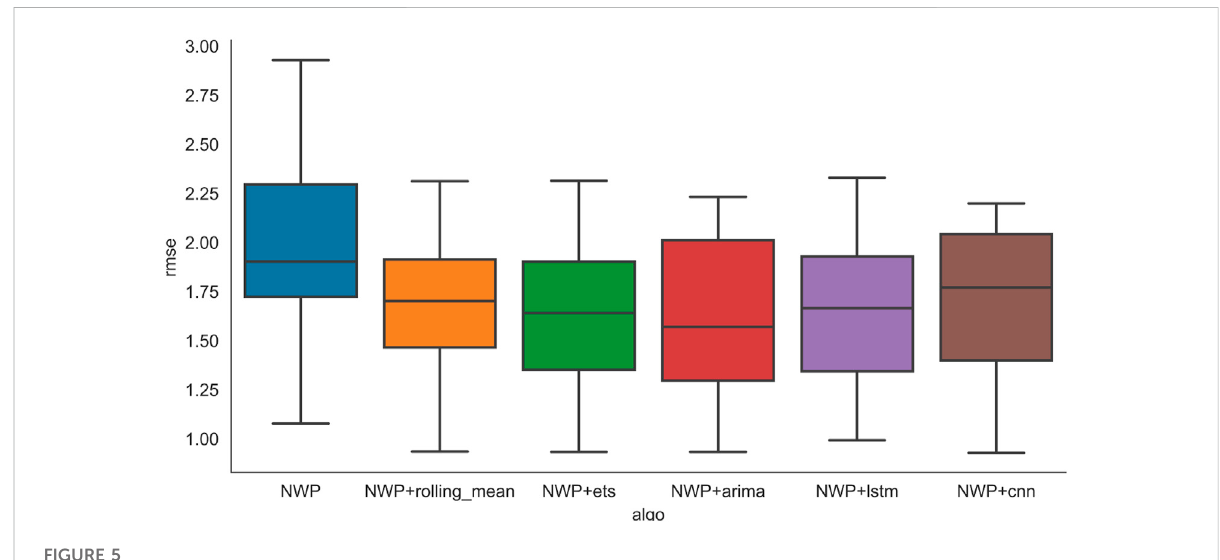
FIGURE 5 Overall rmse results based on the location.